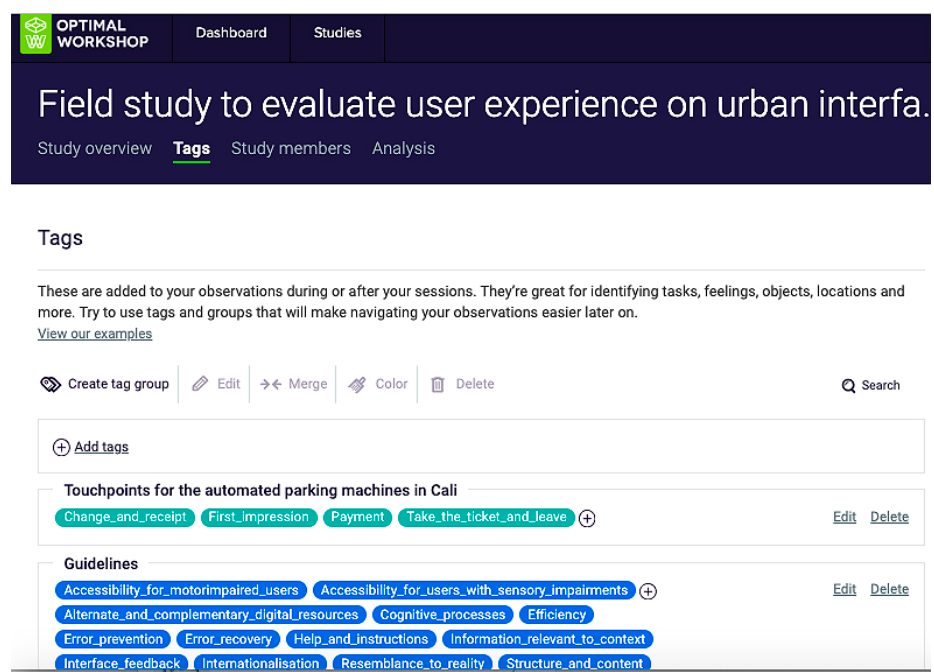
Figure 12. Screenshot of Reframer by Optimal Workshop, a web-based tool used to capture the field notes of each observation.